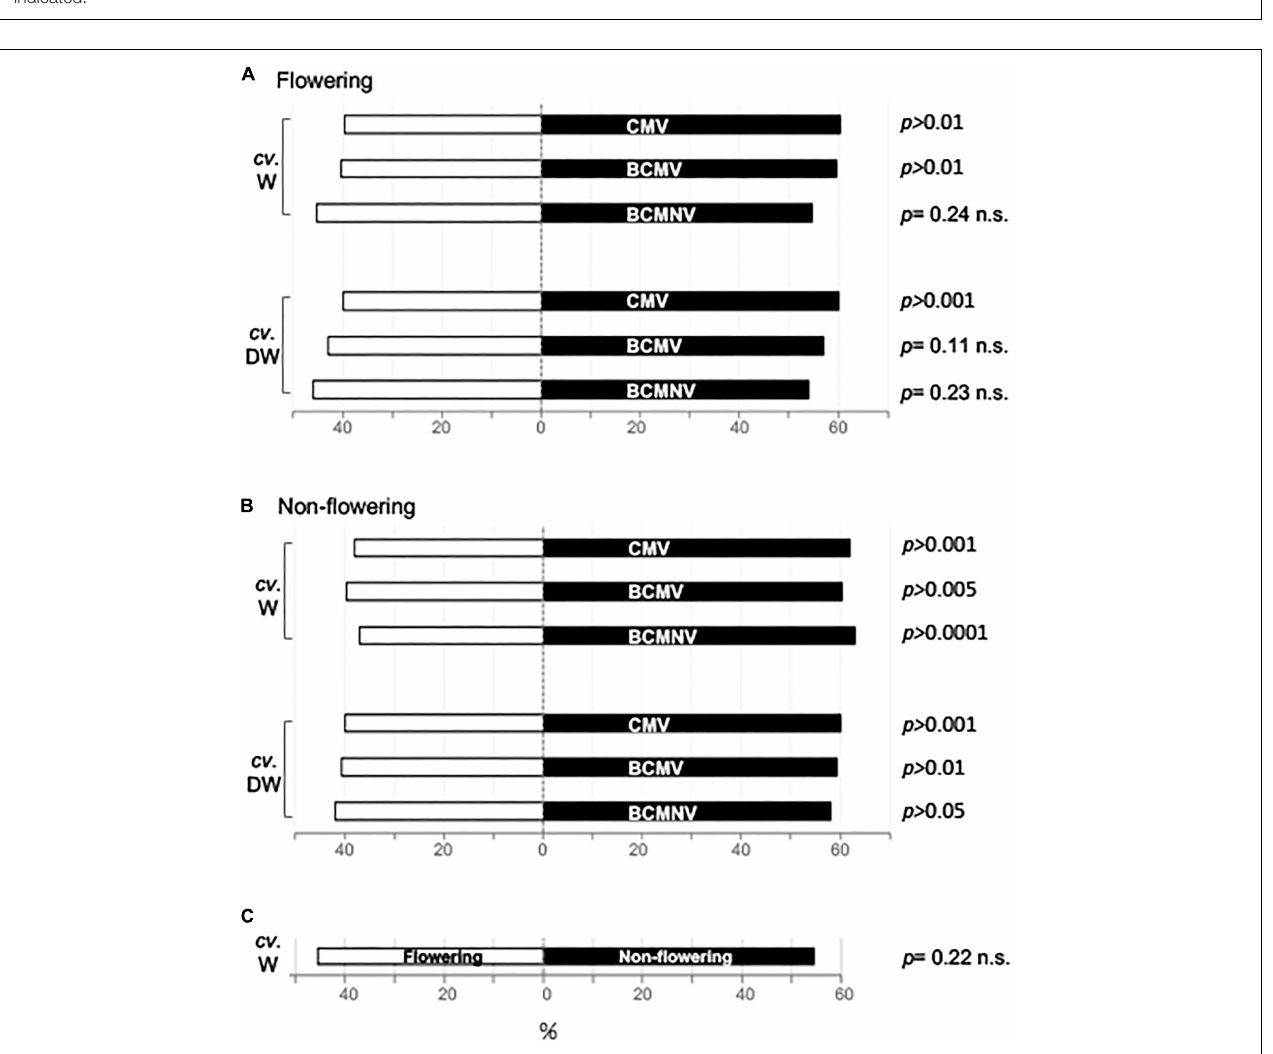
FIGURE 3 | Bumblebees exhibit an innate preference for VOC blends emitted by virus-infected over non-infected bean plants. In free-choice assays, (A) Attraction of bumblebees to VOC blends emitted by flowering virus-infected plants and mock-inoculated plants. (B) Attraction of bumblebees to VOC blends emitted by virus-infected versus mock-inoculated non-flowering plants. (C) Attraction of bumblebees by VOC blends from healthy non-flowering and flowering plants. Plants of two common bean cultivars were used: Wairimu (cv. W) and Dubbele witte (cv. DW). The p -values shown refer to the pooled data of the first 10 choices of 30 (A,B) or 40 (C) naïve bumblebees, and relates to the Wald test of whether the intercept in the fitted binomial generalized linear mixed model was zero, i.e., whether there is any evidence – after controlling for systematic differences between individuals – that bees did anything other than choose at random, with all p -values subjected to a Holm-Bonferroni correction to account for multiple